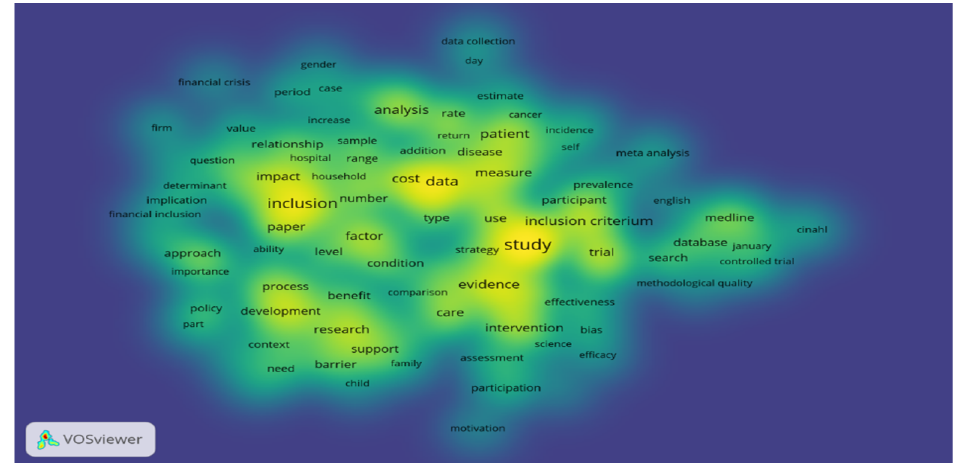
Figure 1. Most common words in scientific publications regarding financial inclusion. The most common word combinations identified in the most relevant studies